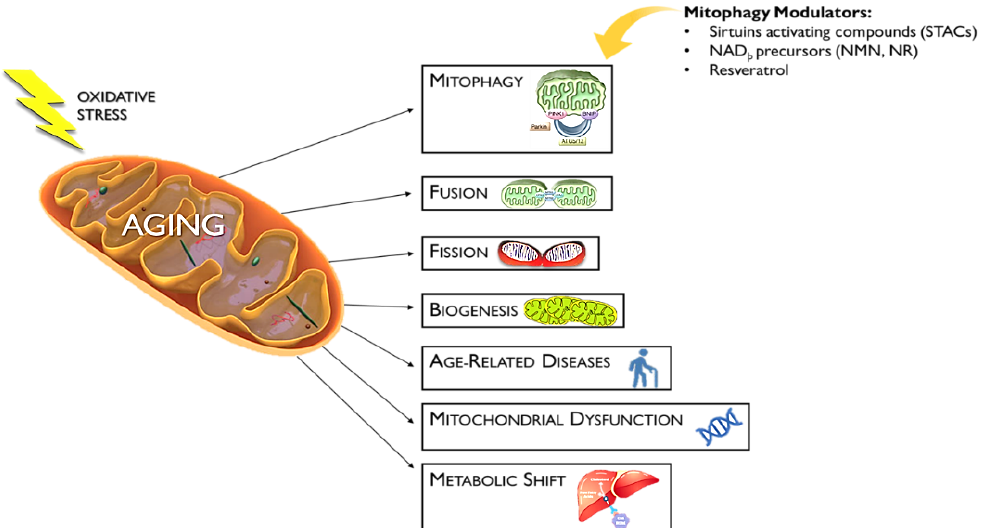
Figure 3. Mitophagy Modulators Against Mitochondrial Dysfunction. Several factors contribute to the aging process via the mitochondria, including mitophagy, mitochondrial fusion and fission, biogenesis, age-related diseases (i.e., AD and PD), mitochondrial dysfunction in general, and metabolic shifts. STACs, NMN, NR, and resveratrol are compounds that act against the aging process, directly targeting mitophagy and preventing the selective degradation of healthy mitochondria.